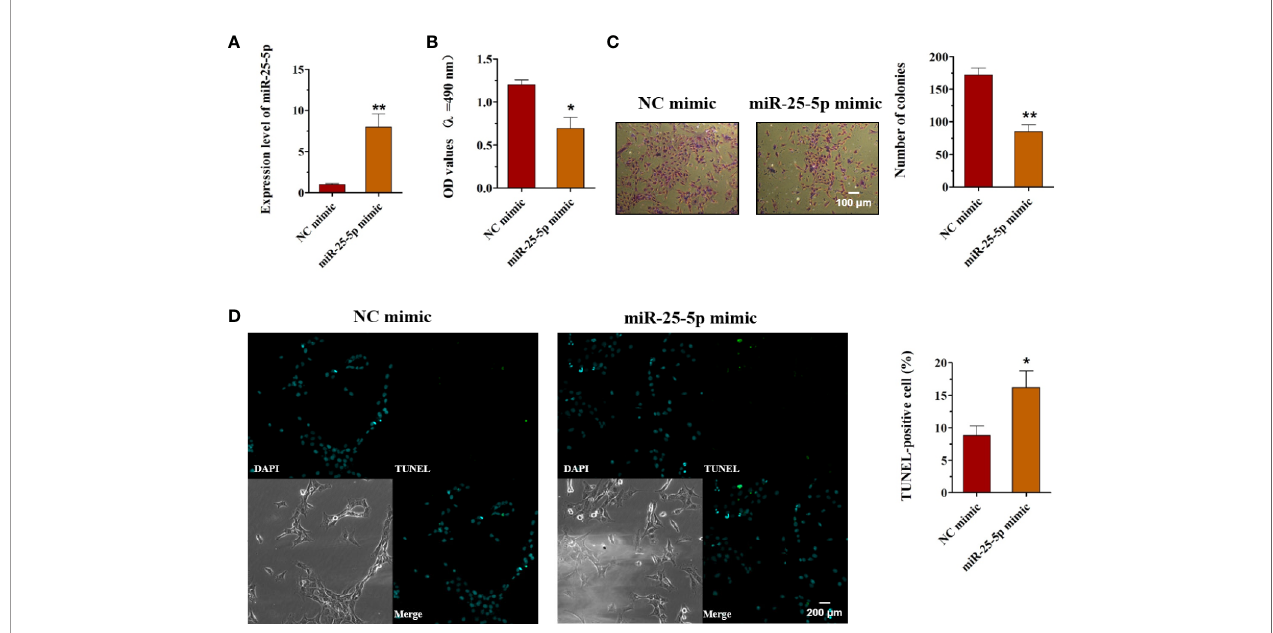
FIGURE 3 | Overexpression of miR-25-5p inhibits the cell viability, proliferation but promotes the apoptosis of OSCC cells. (A) RT-qPCR analysis of miR-25-5p in SCC9 cells transfected with miR-25-5p mimic or NC mimic. (B) MTT assay of cell viability in SCC9 cells treated with miR-25-5p mimic or NC mimic. (C) Colony formation of SCC9 cells exposed to miR-25-5p mimic or NC mimic (Scale bar, 100 m m). (D) The apoptosis of SCC9 cells detected by TUNEL staining. Nuclei were stained by DAPI (blue) stain and apoptotic cells were stained by TUNEL (green) (Scale bar, 200 m m). (n=4, Student ’ s t-test, *p < 0.05, **p <